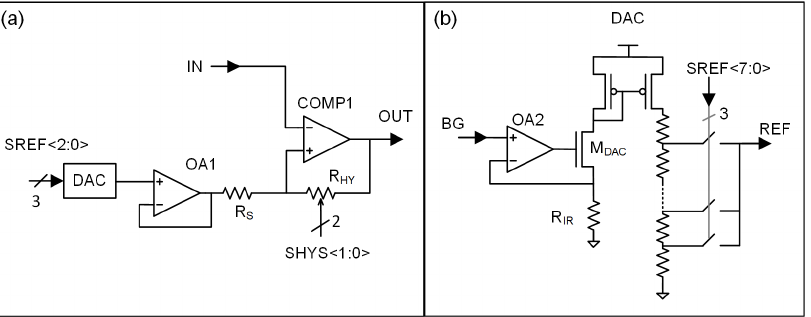
Figure 10. ( a ): Comparator with programmable hysteresis and threshold voltage. ( b ): Schematic diagram of the DAC used to generate the reference voltage for the comparator.